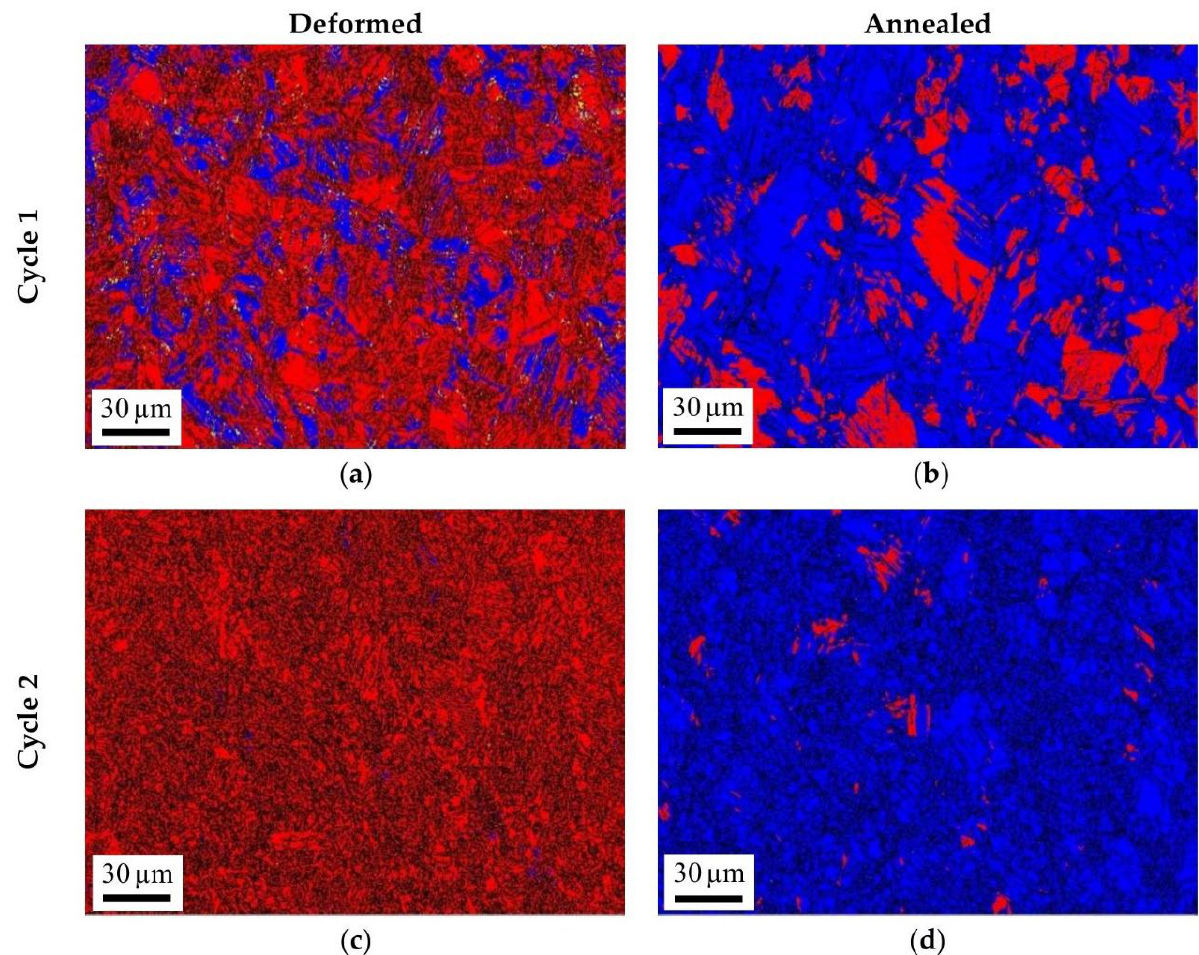
Figure 2. Phase maps for TMP samples processed using two cycles and strain of 0.20: ( a , b ) Cycle 1 and ( c , d ) Cycle 2. Austenite is blue, α′ - martensite is red, and ε -martensite is yellow.